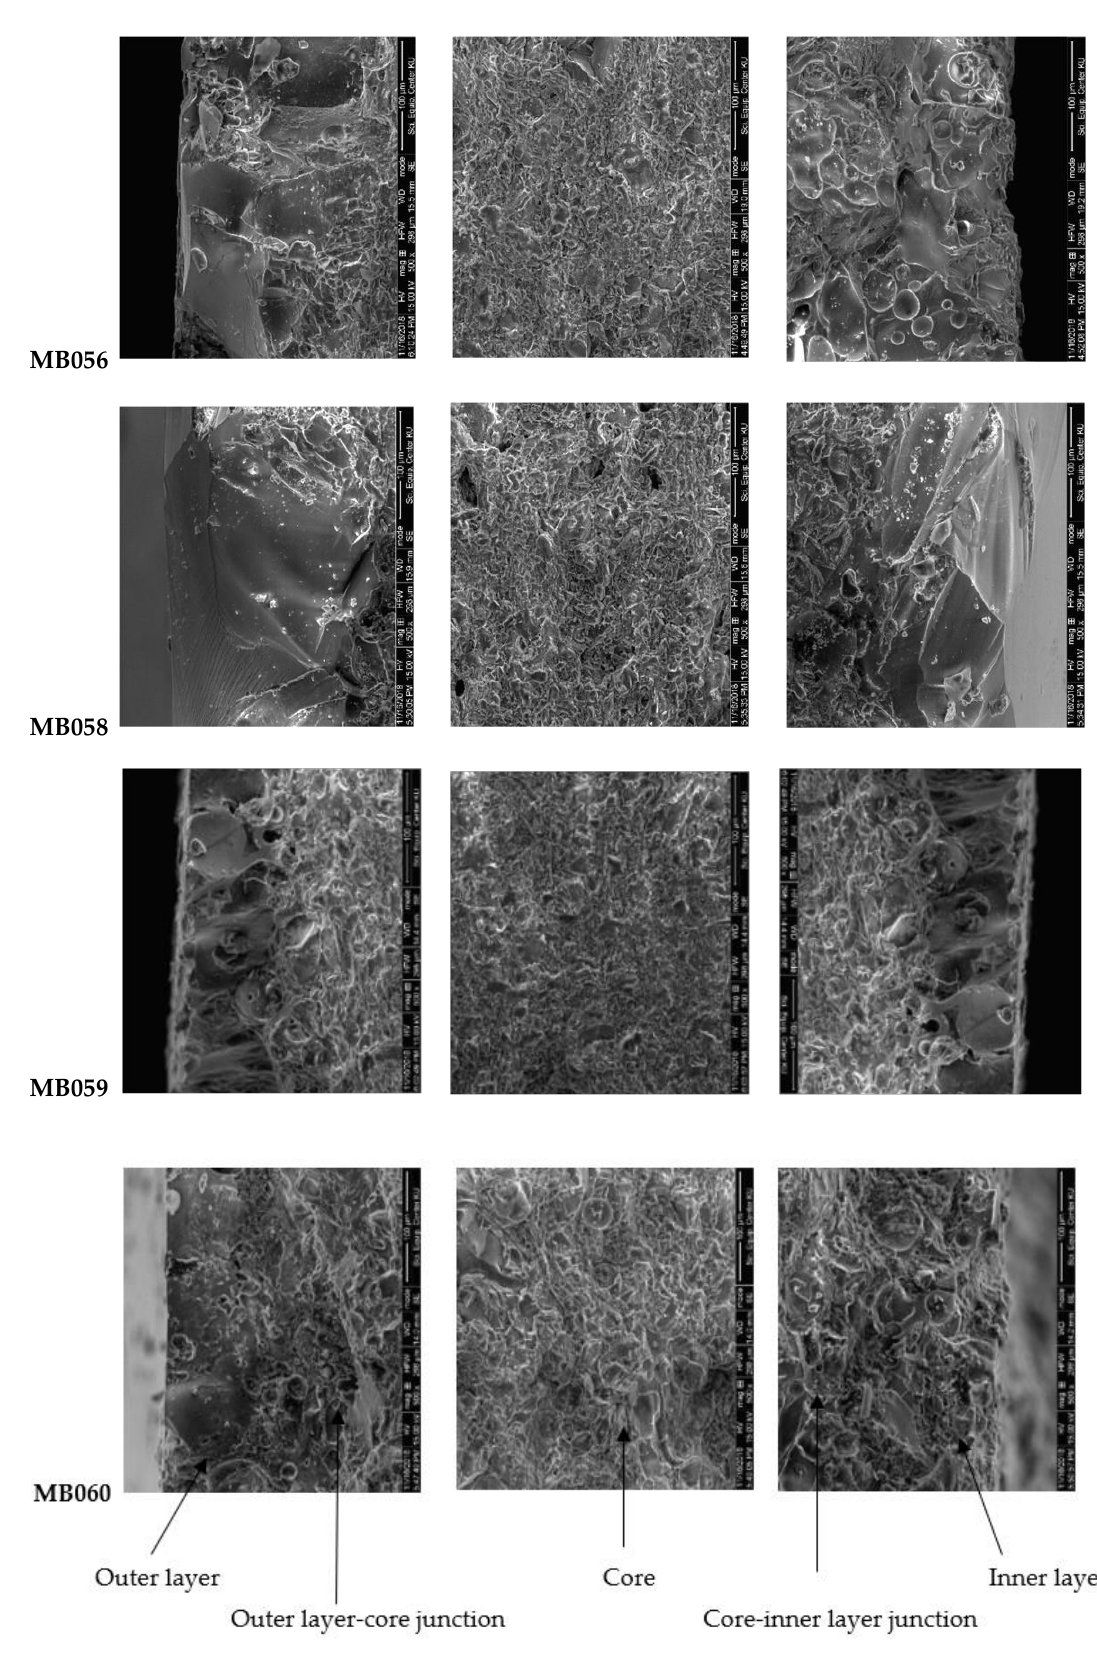
Figure 6. SEM micrographs of outer layer, core, and inner layer of MB051, MB052, MB054, MB055, MB056, MB058, MB059, and MB060.